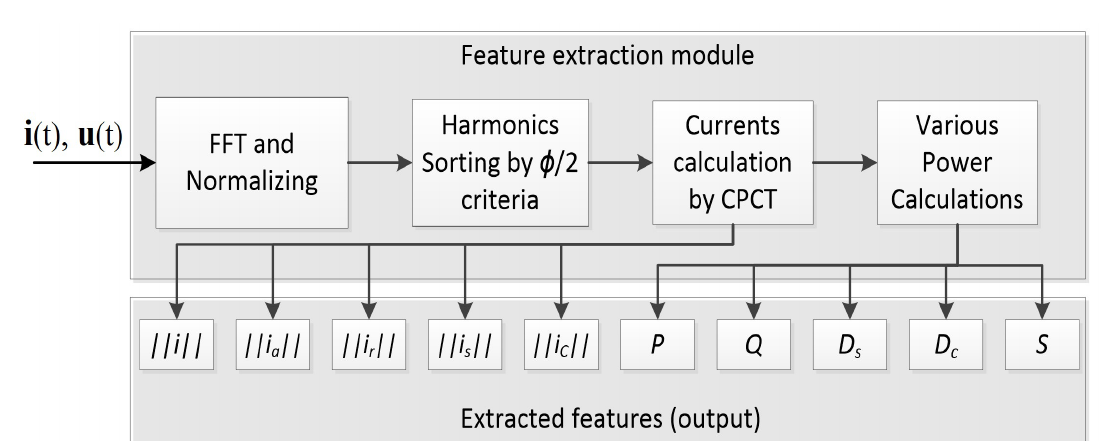
Figure 2. Block diagram of the CPC feature extraction